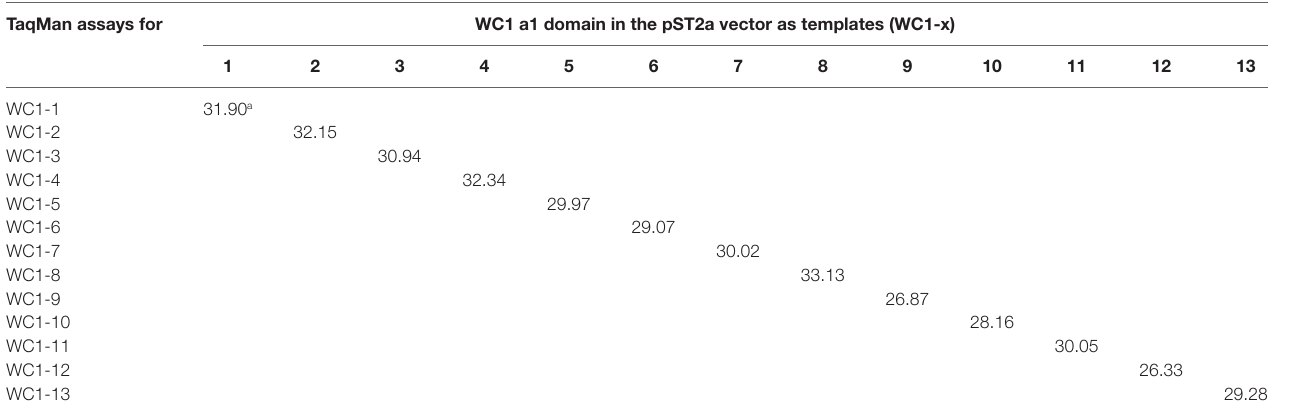
Table 2 | Evaluation of WC1 TaqMan assays for specificity. TaqMan assays